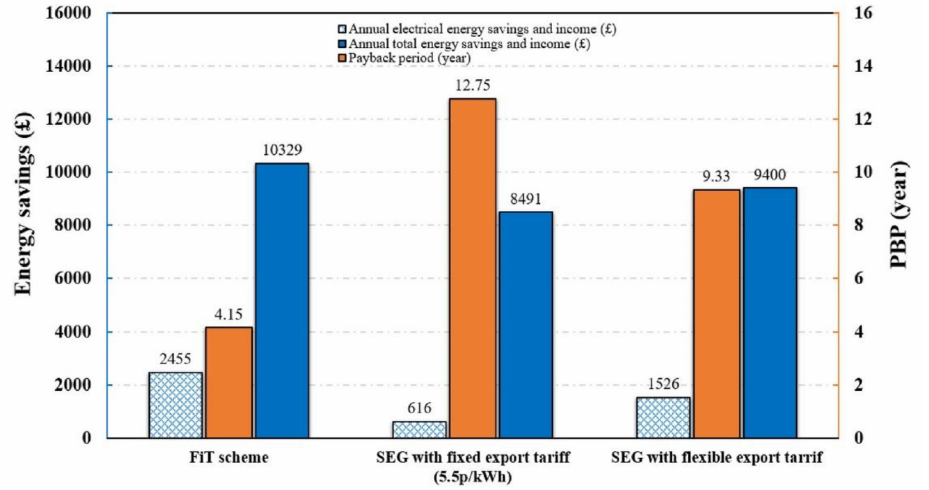
Figure 36. NPV variation as a function of PBP (reprinted from [153], with permission from